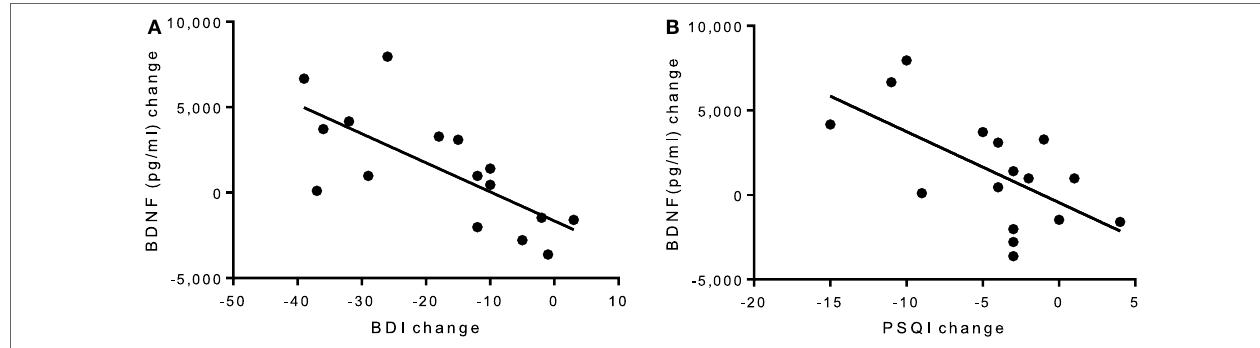
FigUre 3 | (a) Linear regression of pre–post changes for BDI and PSQI scores against BDNF change, irrespective of group. (a) A significant negative correlation was found for (a) BDI scores and BDNF levels ( p = 0.002, R 2 = 0.50) and (B) PSQI scores and BDNF levels ( p = 0.011, R 2 = 0.38), indicating that improvements in depression and sleep quality scores are associated with an increase in BDNF levels. BDI, Beck Depression Inventory; BDNF, brain-derived neurotropic factor; PSQI, Pittsburgh Sleep Quality